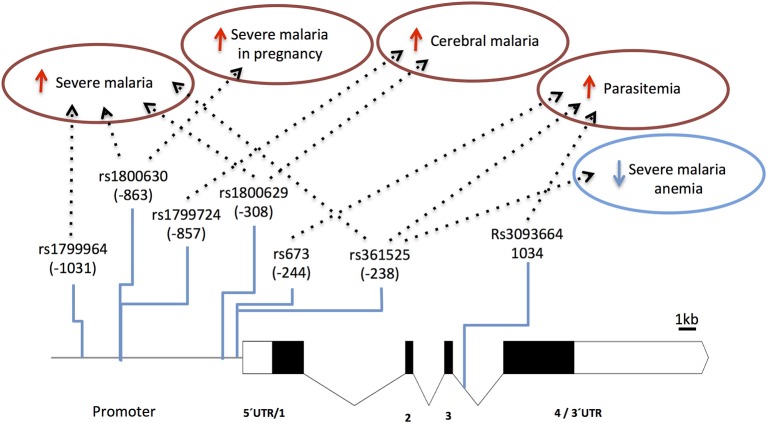
Genetic effects of TNF SNPs associated to clinical malaria. The scaled diagram of exon-intron structure of TNF gene shows malaria associated SNPs in the promoter region and one SNP in intron 3 (bar 1 Kb). Detrimental effects in malaria severity and parasitemia are represented by red arrows while beneficial effects are represented by blue arrows. TNF alleles associated with malaria are conferring several severe phenotypes with the exception of rs361525 that concomitantly is associated to protection from severe malaria anemia. For allele description and reported genetic effects (Supplementary Table 1).